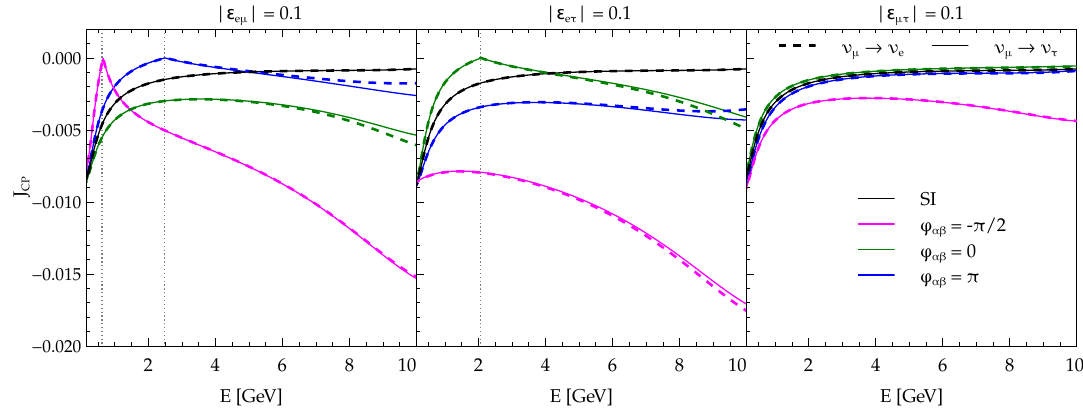
Figure 7 . Evolution of the Jarlskog invariant as a function of energy in the presence of non-zero NSI couplings ( ε eµ , ε eτ , ε µτ ) taken one at a time, as indicated in the plot. The solid (dashed) lines correspond to the ν µ → ν τ ( ν µ → ν e ) appearance channel for different values of the NSI phases, ϕ αβ . Note that, when b N vanishes, α N becomes ill-defined, leading to discontinuities αβ αβ